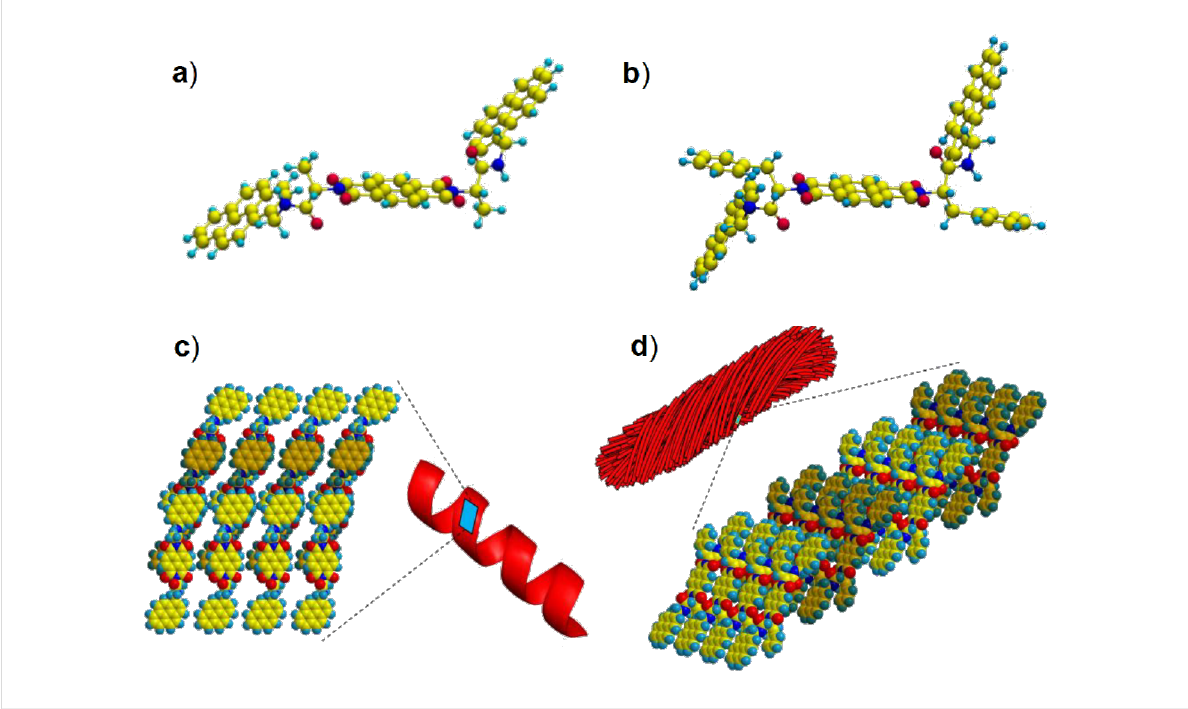
Figure 5: Energy-minimized structures of (a) 1 and (b) 2 . Proposed molecular stacking (Chem3D; space filling model) of topologically symmetric π -complementary pyrene and NDI of (c) 1 and (d) 2 under enhanced hydrophobic forces in aqueous solution. In order to facilitate clarity, the successive layers of D-A-D triads are shown with different contrast in (c) and